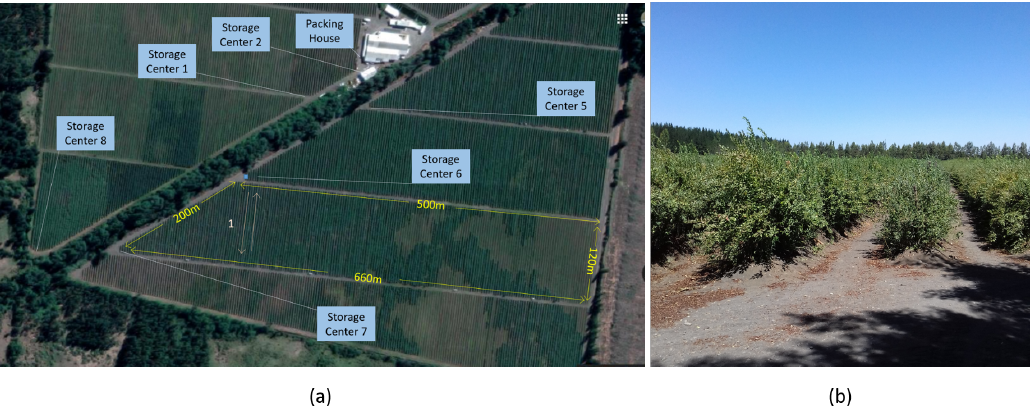
Figure 2. Blueberry orchard in Yungay, Chile. ( a ) Top view showing storage centers and packing house. ( b ) Land view from storage center